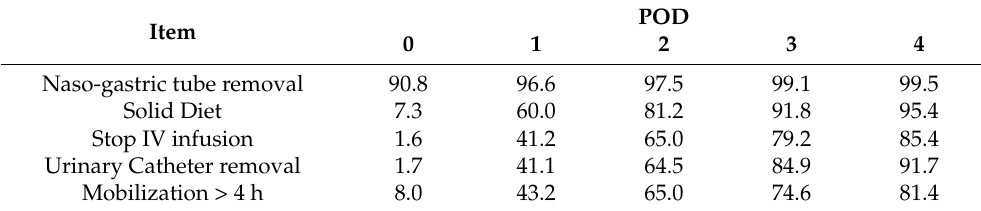
Table 2. Cumulative compliance with postoperative era